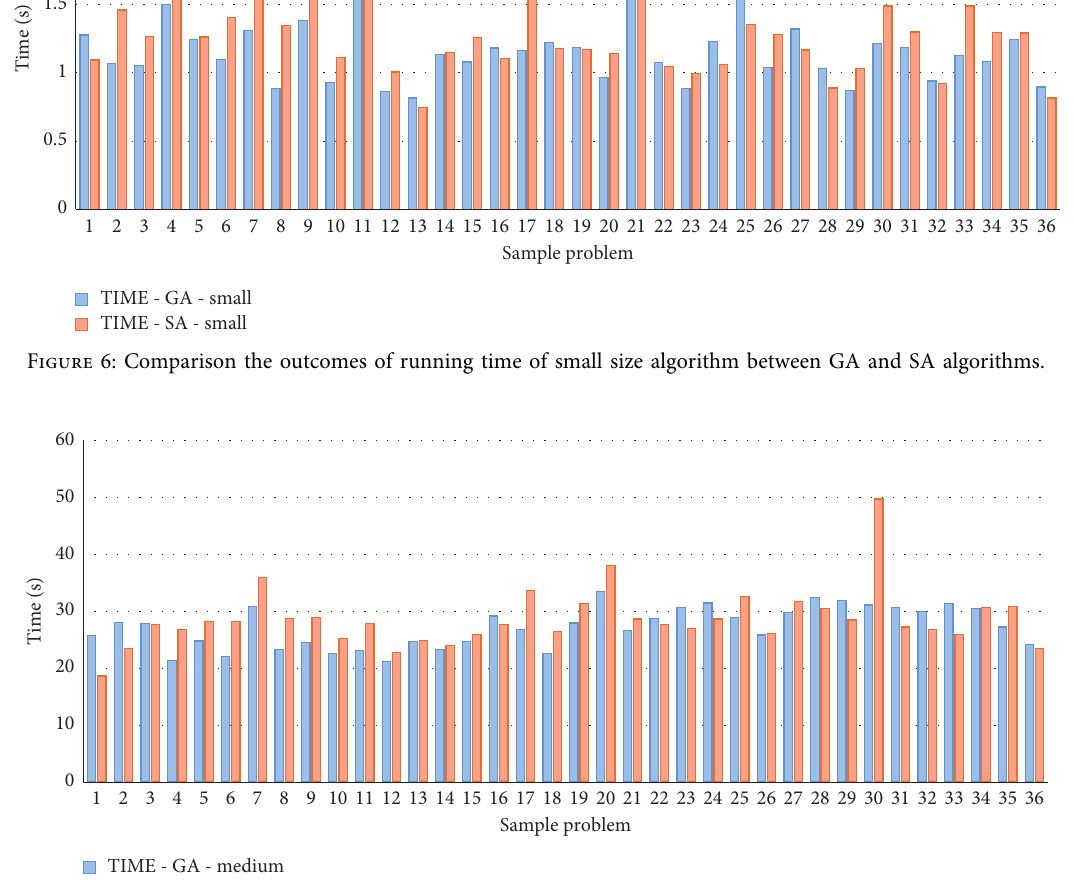
Figure 7: Comparison the outcomes of running time of medium size algorithm between GA and SA algorithms.